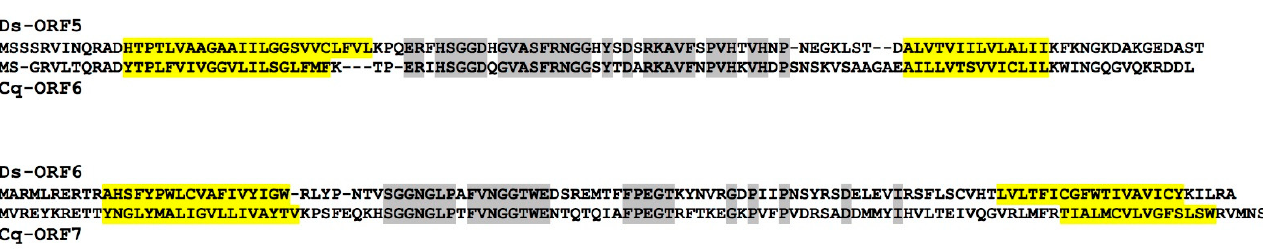
Figure 6. Amino acid sequence of the ORF3 protein encoded by Cq-VLRA2. Positively charged residues are shown in red, negatively charged in blue, cysteine residues in yellow, histidine residues in green. Putative zinc finger motif-containing module is underlined.